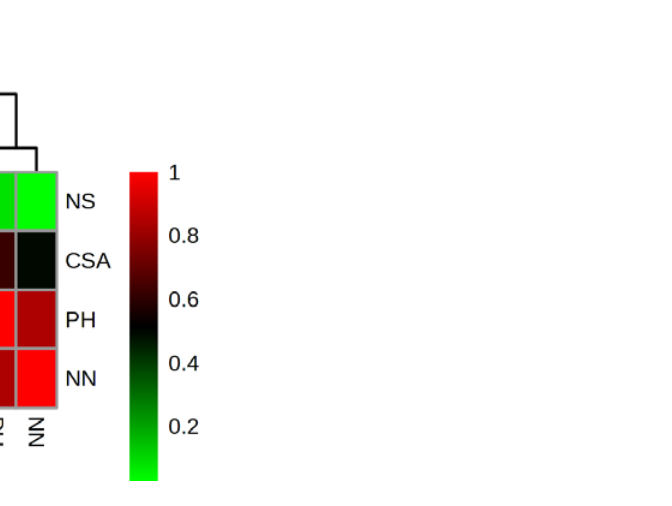
Table 2. Effect of the source of explants and number of subcultures on phenotypical parameters of leaf.